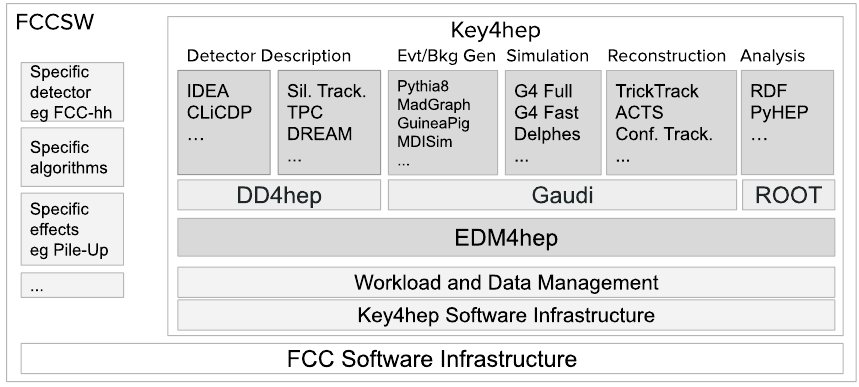
Figure 3. Diagram showing the proposed use of the Key4HEP software stack in the FCC